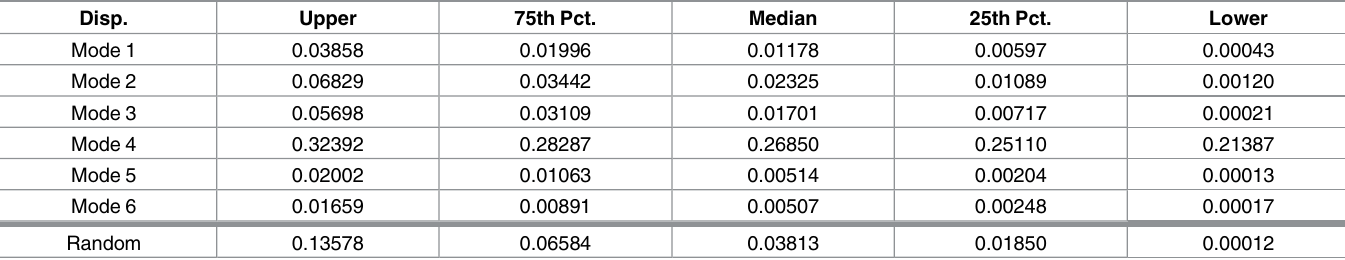
Table 2. Disp. Upper 75th Pct. 25th Pct.